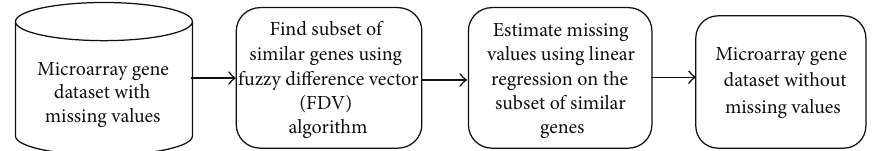
Figure 1: Workflow of the proposed missing value estimation technique.